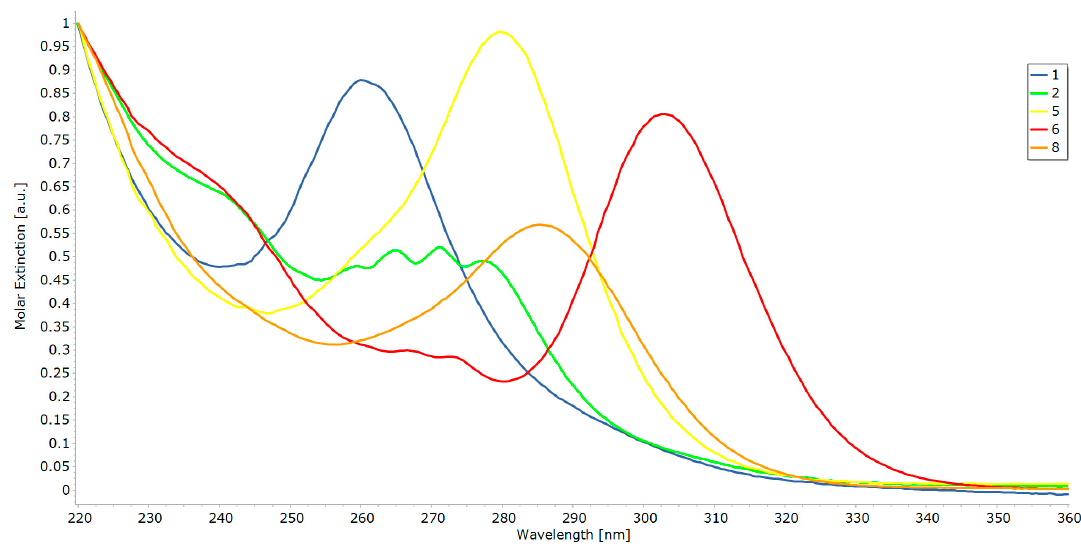
Figure 6. Ultraviolet (UV) spectra of compounds 1 , 2 , 5 , 6 , and 8 .